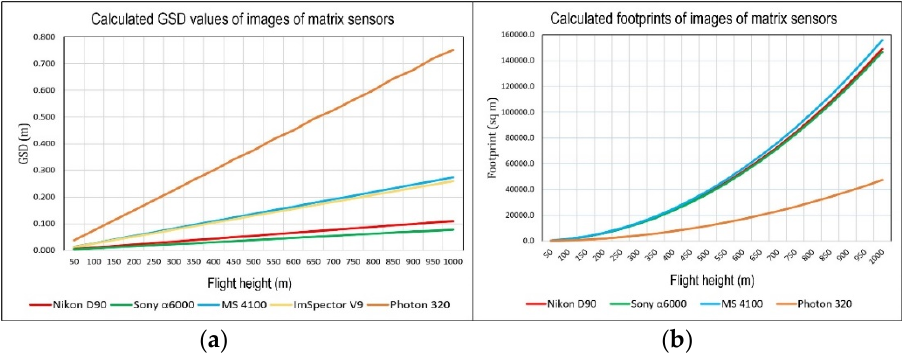
Figure 13. ( a ) Theoretical values of ground sample distance (GSD) of images of more significant AIDSS sensors for flight heights of 50 to 1000 m; ( b ) Theoretical values of image footprints of matrix sensors.